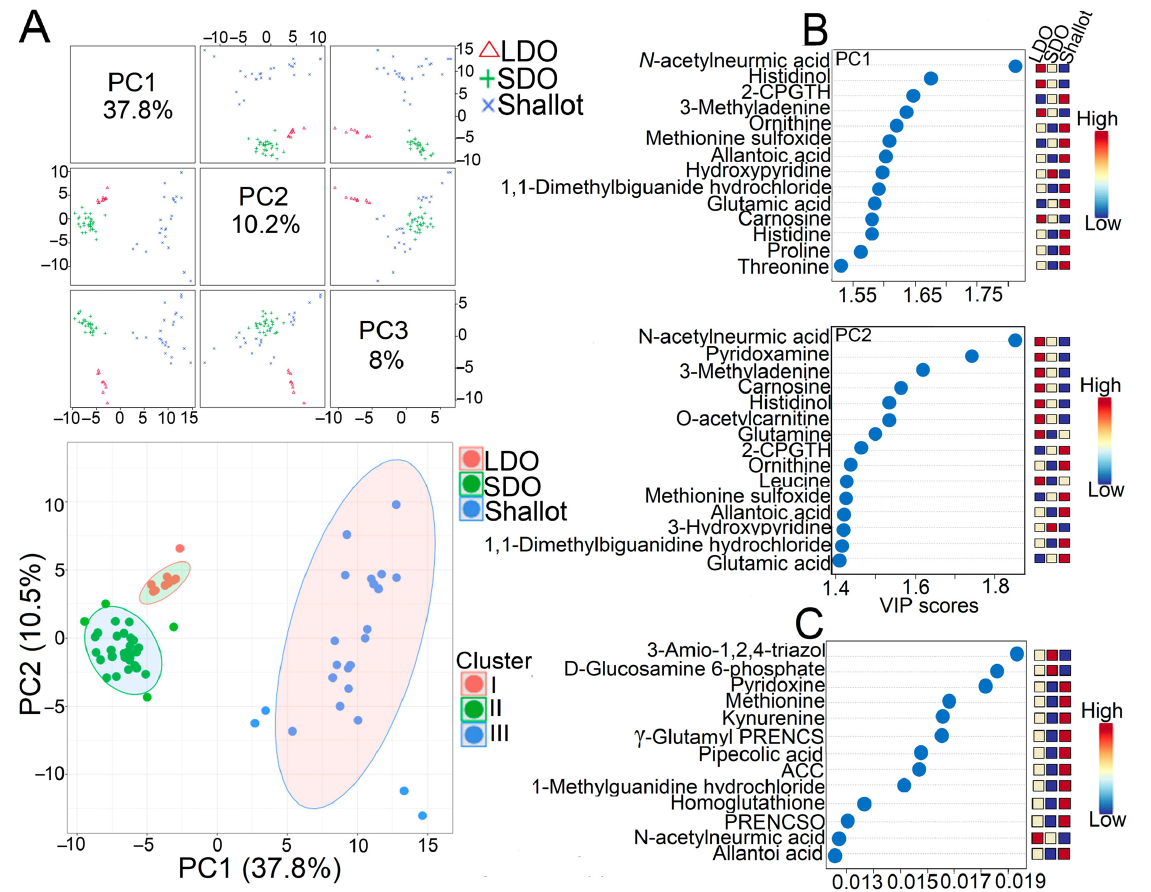
Figure 2. PLS-DA: Partial least-discrimination analysis, VIP: Variable Importance in Projection and Random Forest modeling of the interrelated changes in the metabolite pro-files of Indonesian shallot landraces and Japanese long-day and short-day onions (LDOs and SDOs, respectively). ( A ) PLS- DA Score plot of all 172 variable metabolites identified in the investigated genotypes grown under normal conditions. ( B ) The contribution of each metabolite to PC1 or PC2 axes was colored based on the contribution color scale according to VIP score. ( C ) Random forest variable importance plot. Mean decrease accuracy is the measure of the performance of the model and higher value indicates the importance of that metabolite in predicting group. 2CPGTH, S-2